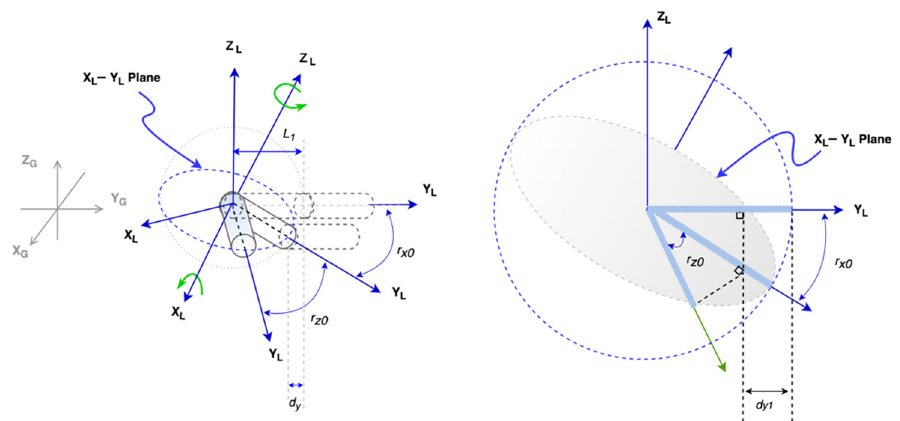
Figure 6. Shifts after two rotations.